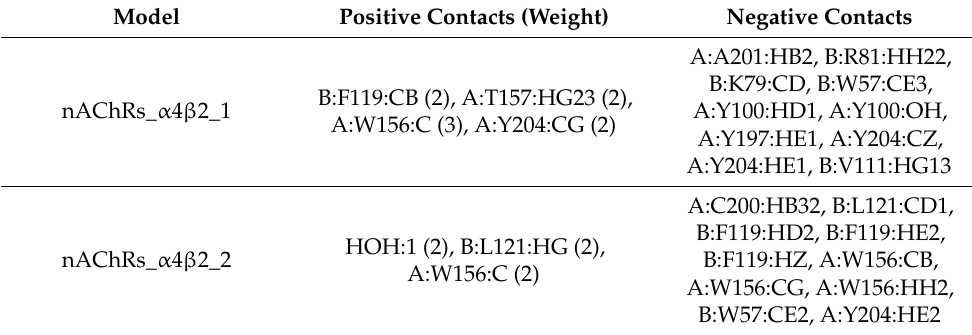
Table 2. Critical contacts for the two best dbCICA models for ( α 4) 2 ( β 2) 3 receptor.